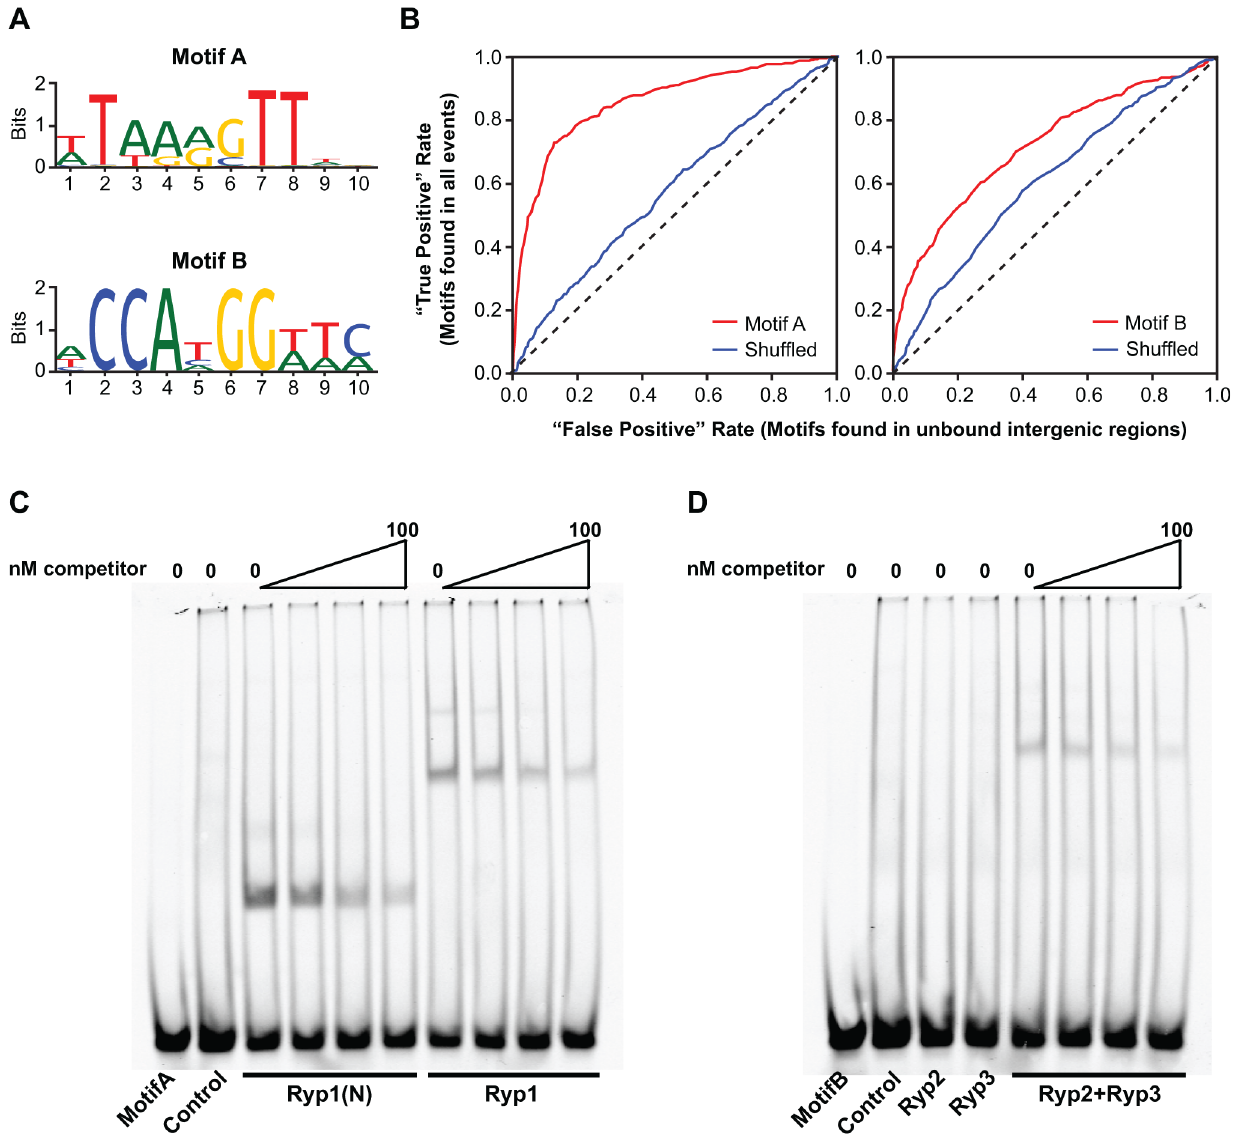
Figure 6. Ryp factors bind to specific cis -acting regulatory elements. (A) Motif A and Motif B logos are shown. (B) Motif specificity of Motif A, Motif B, and their shuffled versions were analyzed by ROC plots. True positive rate was defined as motifs found in all ChIP events. False positive rate was defined as motifs found in unbound intergenic regions. (C, D) His-tagged Ryp proteins were generated by a coupled in vitro transcription- translation reaction in wheat germ extracts, and purified using Ni-NTA beads. Extracts with no template DNA were processed similarly and included as controls. 60-bp fragments from the CBP1 promoter were used as Motif A and Motif B probes (Figure 3B). 1 nM labeled probe and 2 m g of purified protein were used for each binding reaction. Binding to labeled Motif A or Motif B probes was competed by adding unlabeled probe in 10-fold, 50- fold, and 100-fold molar excess of the labeled probe.